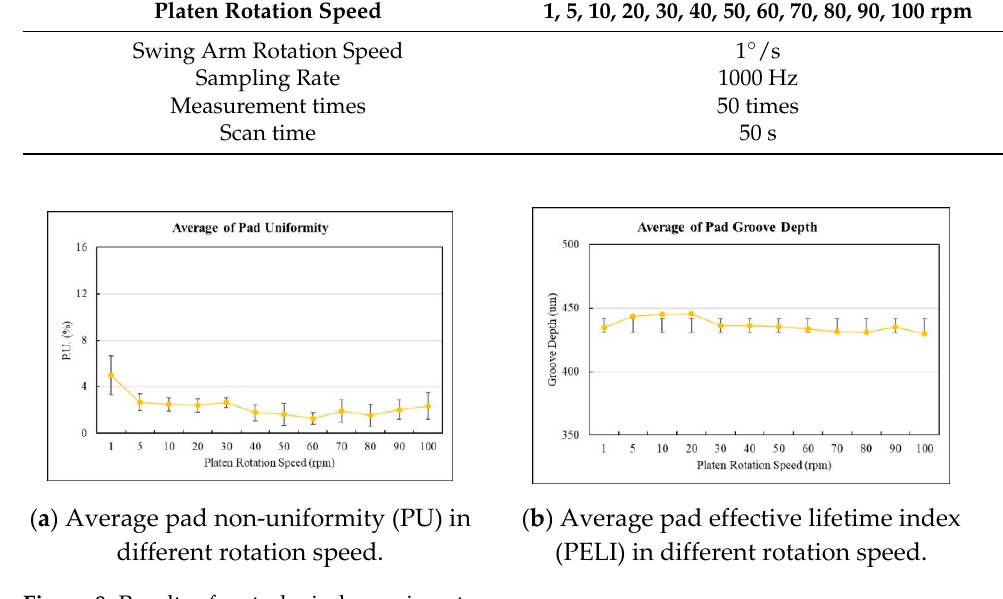
Figure 8. Results of metrological experiments.